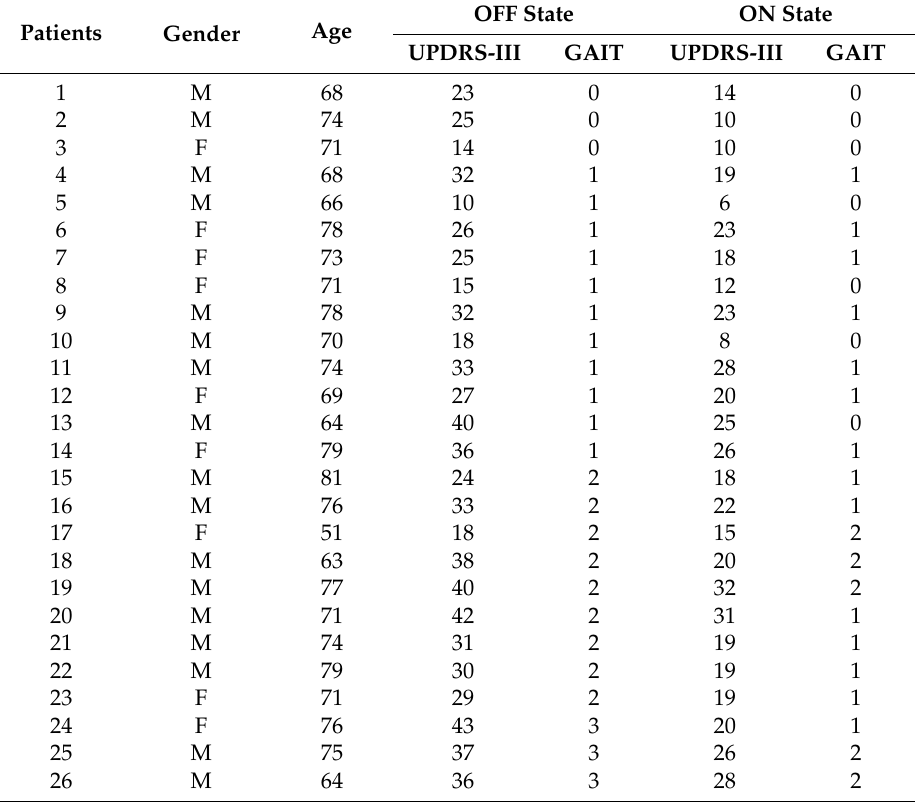
Table 1. Demographic data of PD patients. Patients’ motor condition is reported both in OFF and ON state as UPDRS-III score and GAIT item (0 = Normal; 1 = Mild difficulty, may not swing arms or may tend to drag leg; 2 = Moderate difficulty, requires little or no assistance; 3 = Severe disturbance of walking, requiring assistance).